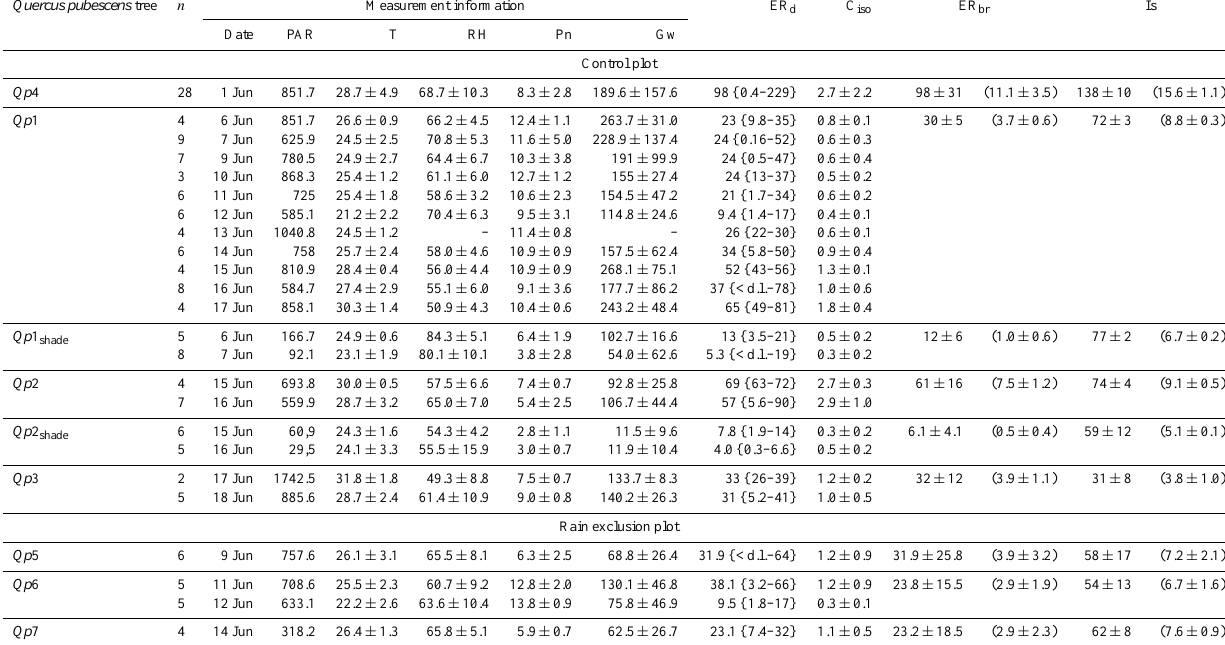
Table 2. Environmental and physiological parameters recorded during isoprene measurements on seven sunlit ( Qp i) and two shaded ( Qp i shade ) Q. pubescens branches. PAR (µmolm − 2 s − 1 ) , temperature T ( ◦ C), relative humidity RH (%), photosynthetic net assimilation 22:00. Daily emission rates ER d (µgCg − 1 h − 1 ) were averaged over the n isoprene measurements of the sampled branch; values in brackets DM are minimum–maximum. Assimilated carbon emitted as isoprene C iso (%) is given ± SD. For every branch, isoprene emission rates ER br and emission factor Is (as in Guenther et al. 1993) ± SD are given inµgCg − 1 h − 1 and ngCm − 2 h − 1 (in parentheses). DM Quercus pubescens tree